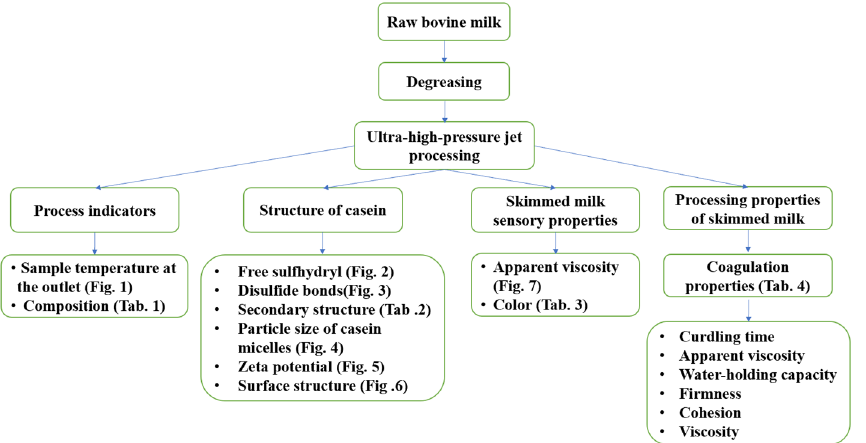
Figure 8. Flow chart of the experiment.